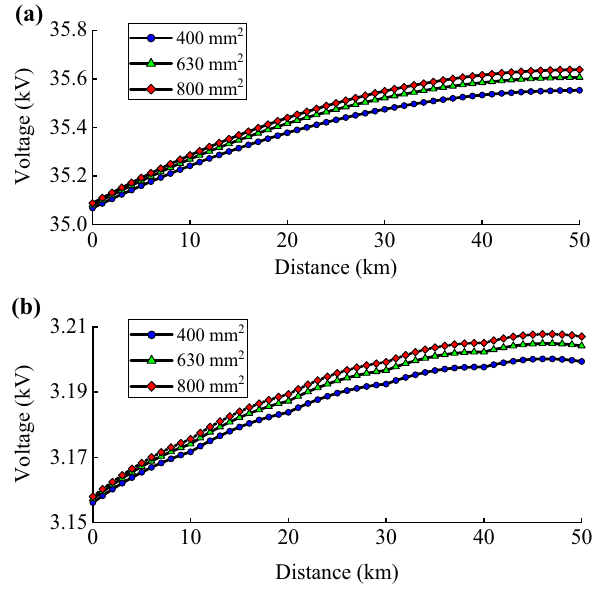
Fig. 15 Voltage distribution of system under no-load condition: a CTN; b